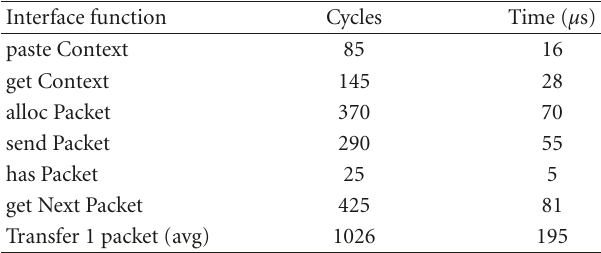
Table 2: Cycle count of the most important titan interface